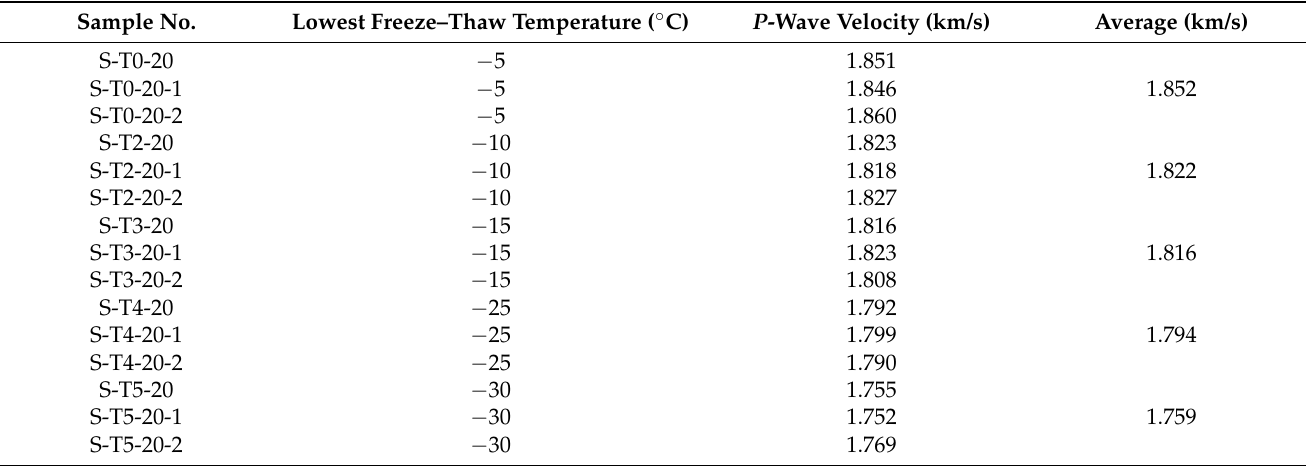
Table 3. P -wave velocity after 20 freeze–thaw cycles with different freeze–thaw temperatures. Sample No.